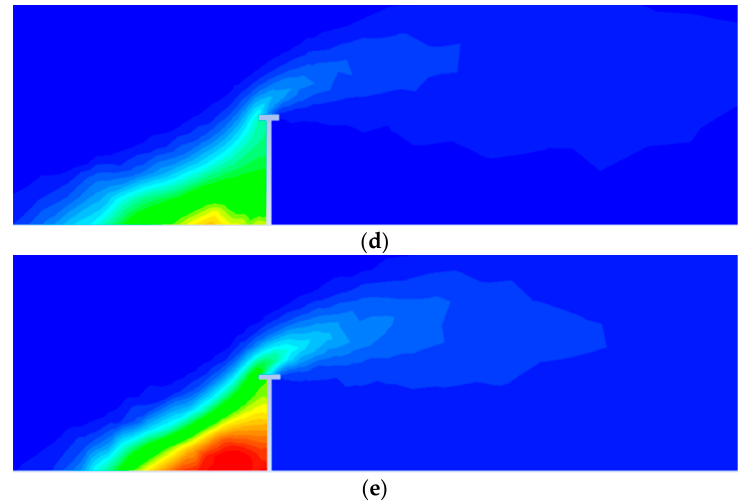
Figure 12. Contours of CO molar concentration for different barrier shapes (H = 9 m). ( a ) Base case; ( b ) case 1; ( c ) case 2; ( d ) case 3; ( e ) case 4.